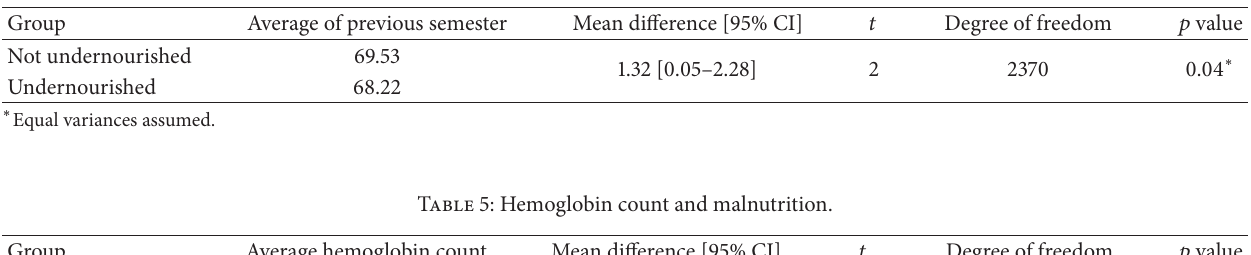
Table 4: School performance and malnutrition.